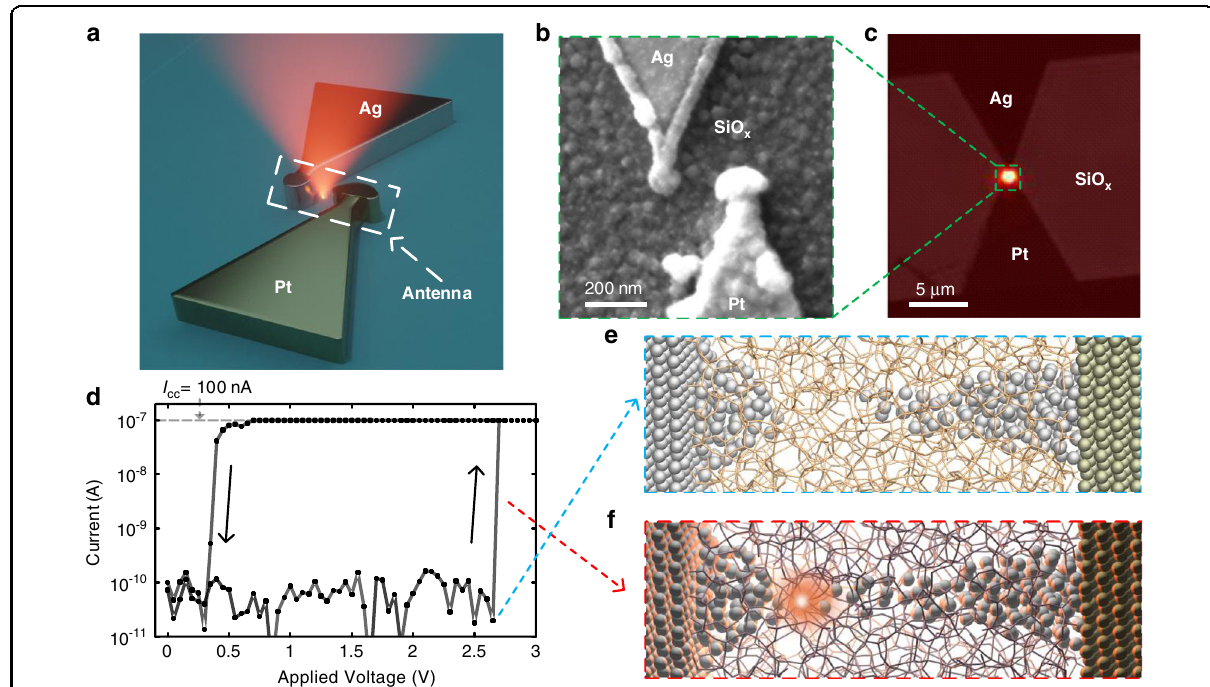
Fig. 1 Overview of an atomic photon source (APS). a Schematic illustration of the atomic scale memristive photon source (APS) with the plasmonic nanoantenna (highlighted in white dashed box) forming the tips of the quasi-triangular-shaped Ag and Pt electrodes. b SEM image of one APS. The nanoantennas can be seen at the apex of the Ag and Pt electrodes. A layer of 60 nm sputtered SiO x covers the chip and serves as the switching matrix. c Overlay of a wide- fi eld electroluminescence image with an optical transmission image from the APS. The electroluminescence image of the APS is taken accompanying a resistive switching I – V voltage sweep. The bright spot signals photons emitted from the gap. The two images are overlaid to distinguish the con fi guration of the electrodes (darker areas). d A typical I – V curve for a voltage sweep of the APS, demonstrating a hysteresis behavior characteristic of a memristor. The photon emission is associated with the abrupt change of current, highlighted by the black arrows. Upon switching to the low resistance state, a compliance current of I cc = 100 nA limits the maximum current fl owing through the device. e Schematic illustration of the APS at the atomic level at the beginning of fi lament formation and device switching into the low resistance state. The grey spheres illustrate the Ag atoms constituting the active electrode and the fi lament. The green spheres represent the inert Pt electrode. The orange matrix mimics the a-SiO x lattice. The Ag protrusions from both electrodes result from repeated Ag fi lament formation and dissolution from resistive switching cycles. f Schematic illustration of the atomic photon source emitting photons during the memristive switching process. The Ag fi lament is growing from the Pt towards the Ag electrode. The bright red spot represents the emitted photons at a likely origin in the gap of